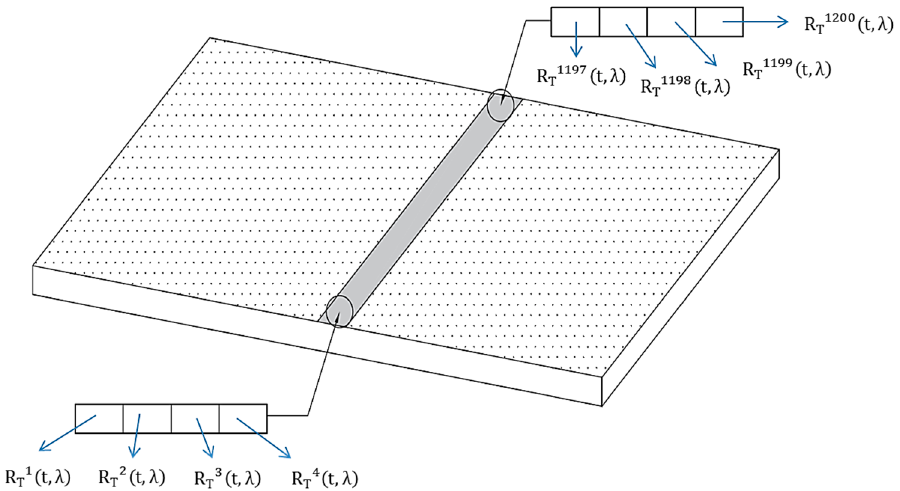
Figure 9. Different reflectance measurements on different points on a single tow section.